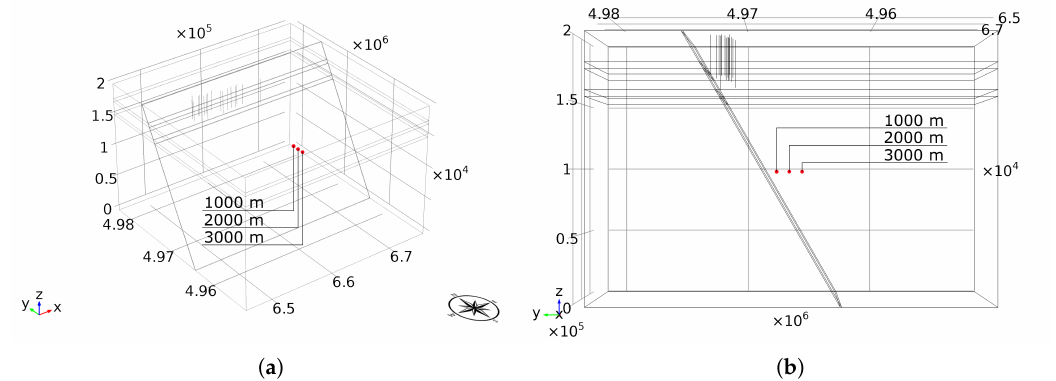
Figure 17. Mirandola fault and Cavone oilfield modeling—location of the three points at different distances from the hypocentre in the negative y -direction; ( a ) prospective view; ( b ) lateral view; dimensions are in meters (10 5 in x , 10 6 in y - and 10 4 in z